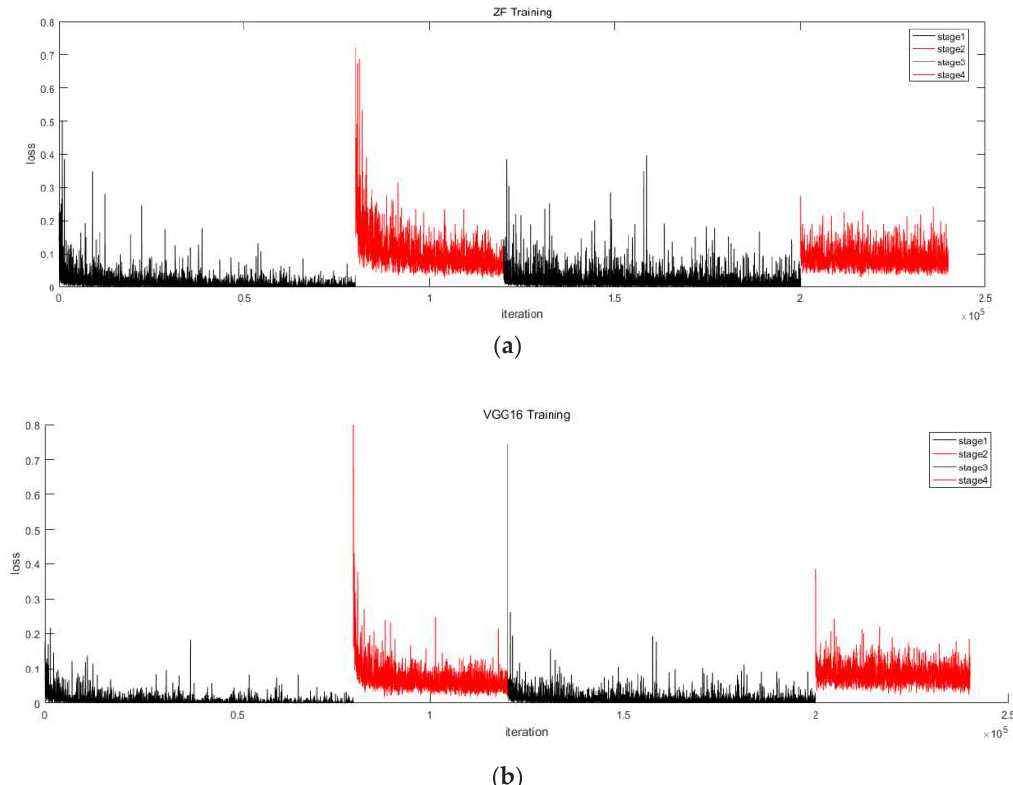
Figure 8. The loss value of Faster R-CNN training. ( a ) Using the ZF-net. ( b ) using the VGG16-net.